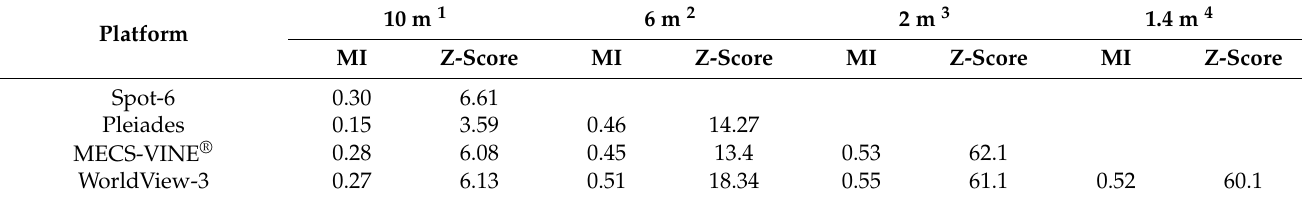
Spatial weight matrices were calculated using queen contiguity approach with the first order of neighbors. Critical Z score values were considered using a 99% confidence level, significance was considered for results with a Z score values below − 2.576 and above +2.576. 1 , n = 90. 2 , n = 297. 3 , n = 2427. 4 , n =